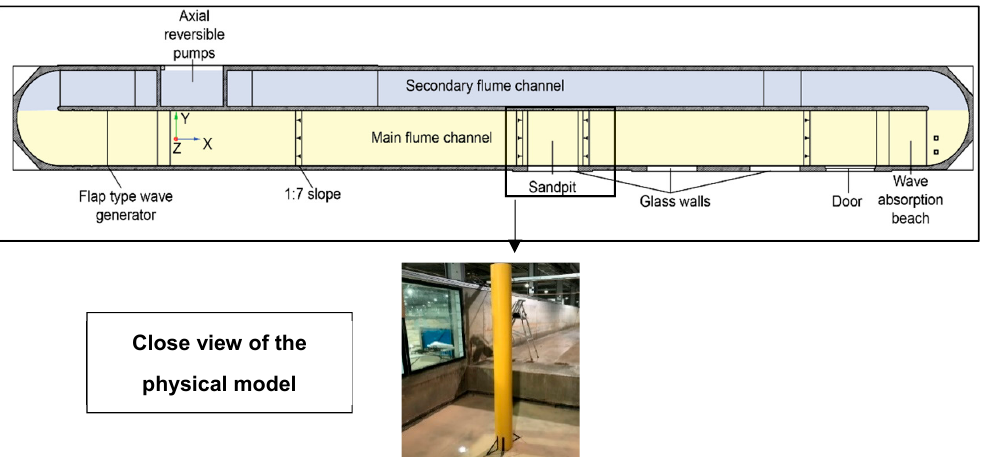
Figure 1. Sketch of the fast flow facility (FFF) flume channels including the position of the scale models.